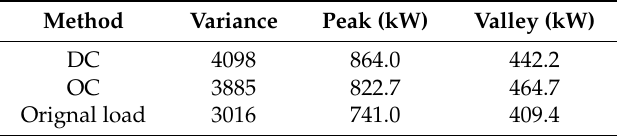
Figure 8. Optimization of the distribution network load. Table 3. Load variance comparison of disordered charging and ordered charging.